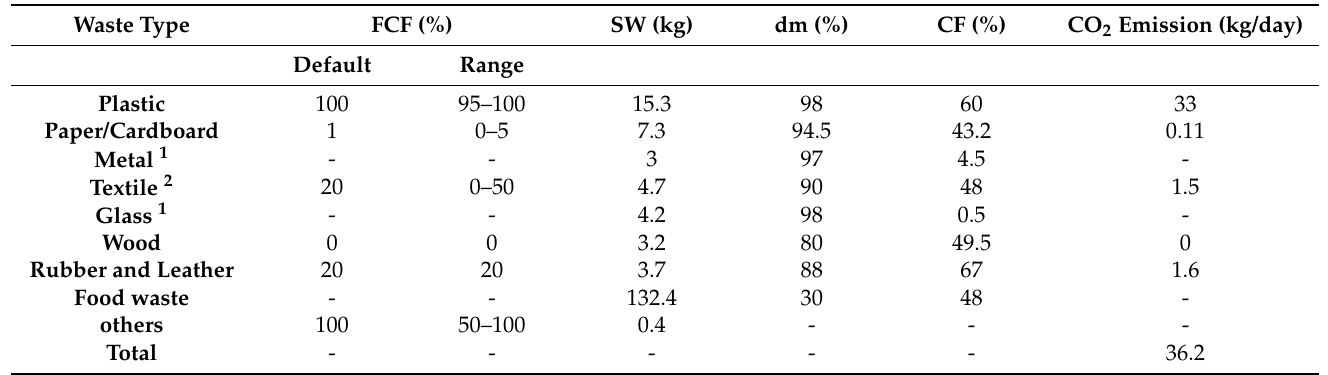
Table 15. CO 2 emission per day by MSW incineration [54].